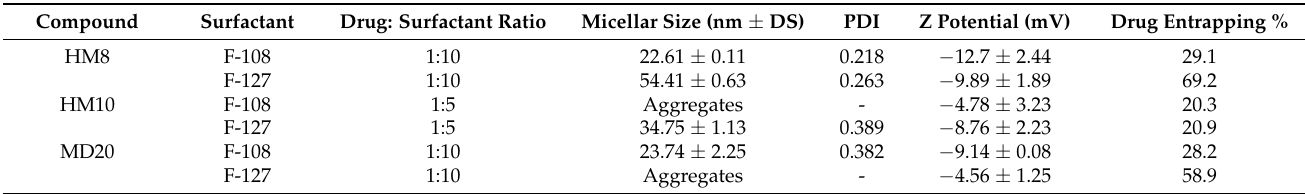
Table 1. Characteristics of the Pluronic micellar